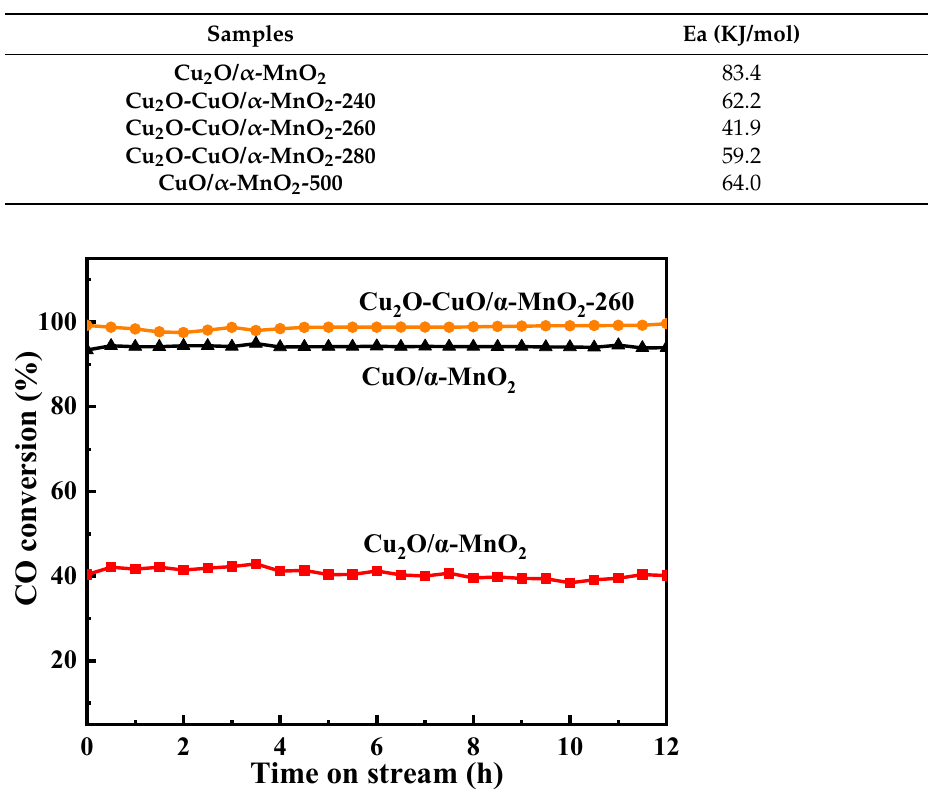
Figure 4. Results of 12 h long-term stability tests over the as-prepared Cu 2 O/ α -MnO 2 , Cu 2 O-CuO/ α -MnO 2 -T, and CuO/ α -MnO 2 -500 catalysts; reaction conditions: CO/O 2 /N 2 = 1/20/79, GHSV = 12,000 mL g − 1 h − 1 , 1 atm.